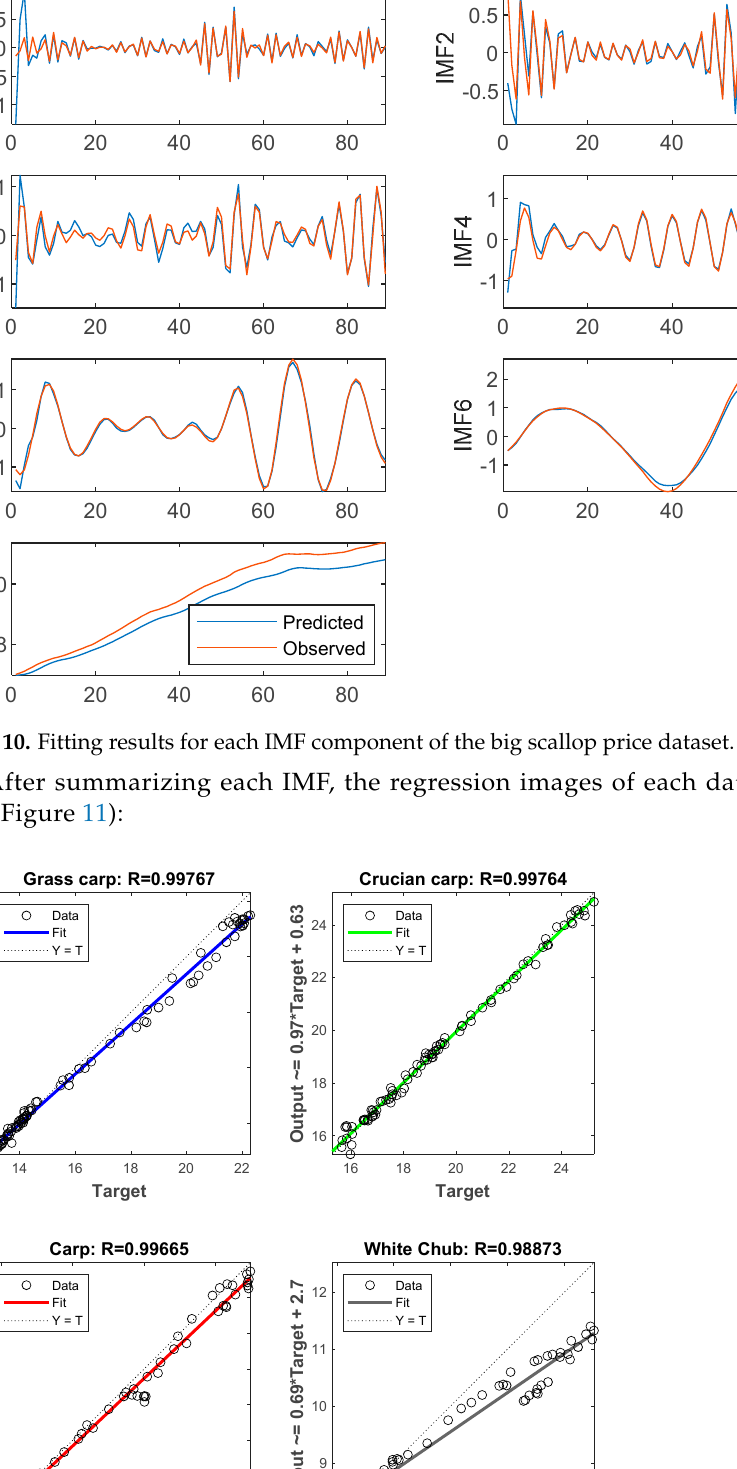
Figure 9. Fitting results for each IMF component of the white chub price dataset.